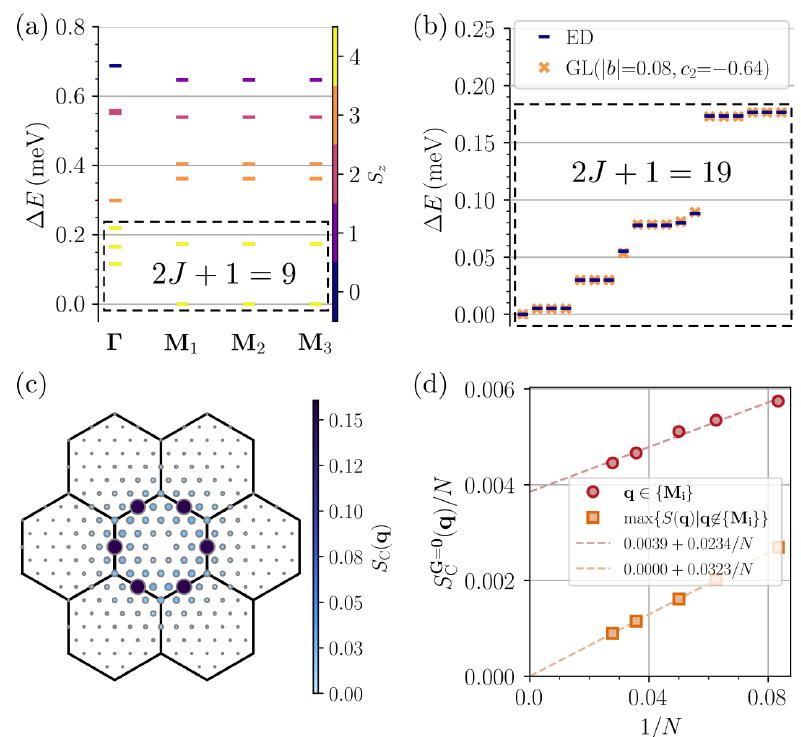
Figure 5: ED evidence for ferromagnetic charge order with an approximate O p 3 q { w “ 0.9. (a) The lowest energy states are completely spin polar- symmetry at w AA AB ized and have center of mass momenta Γ and M . (b) The 2 J ` 1 lowest levels are j nearly degenerate, approximating an O p 3 q symmetric manifold of states. The rela- tively minor splitting is well described by an effective O p 3 q theory with cubic | b | ą 0 ă 0 anisotropies. (c)-(d) Measurements of the charge structure factor and quartic c 2 strongly point to the formation of a q “ M charge density wave. The contributions j at q “ 0 in (c) (here N “ 36) and (d) are discarded and the values of b and c in (b) 2 are given in units of meV. G “ 0 indicates momentum transfers q located in the first moiré Brillouin